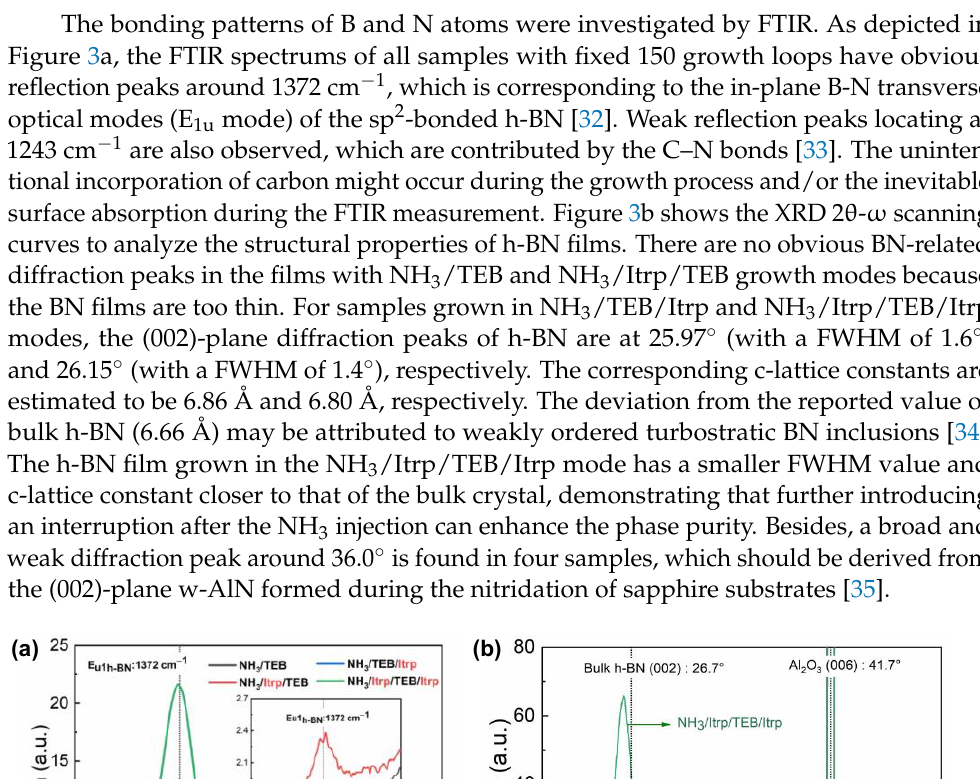
Figure 2. The SEM images of BN films with fixed 150 growth loops under four FME modes: ( a ) NH 3 /TEB, ( b ) NH 3 /Itrp/TEB, ( c ) NH 3 /TEB/Itrp, ( d ) NH 3 /Itrp/TEB/Itrp. White crossed line segments within wrinkled domains in ( c , d ) are used to estimate the wrinkle wavelength.